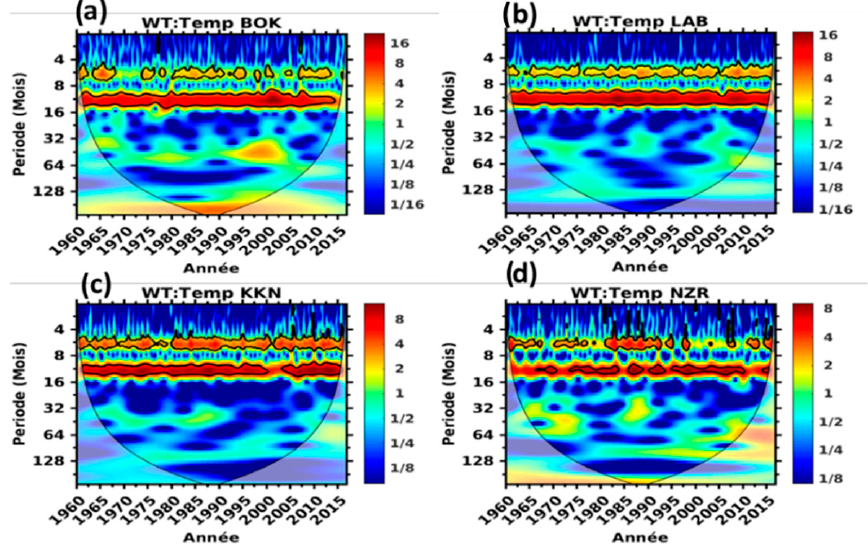
Figure 6. Dominant modes of variability detected by wavelet transform (WT) at 4 selected sites representative of each region: ( a ) Boke, ( b ) Labe, ( c ) Kankan and ( d ) N’zerekore.